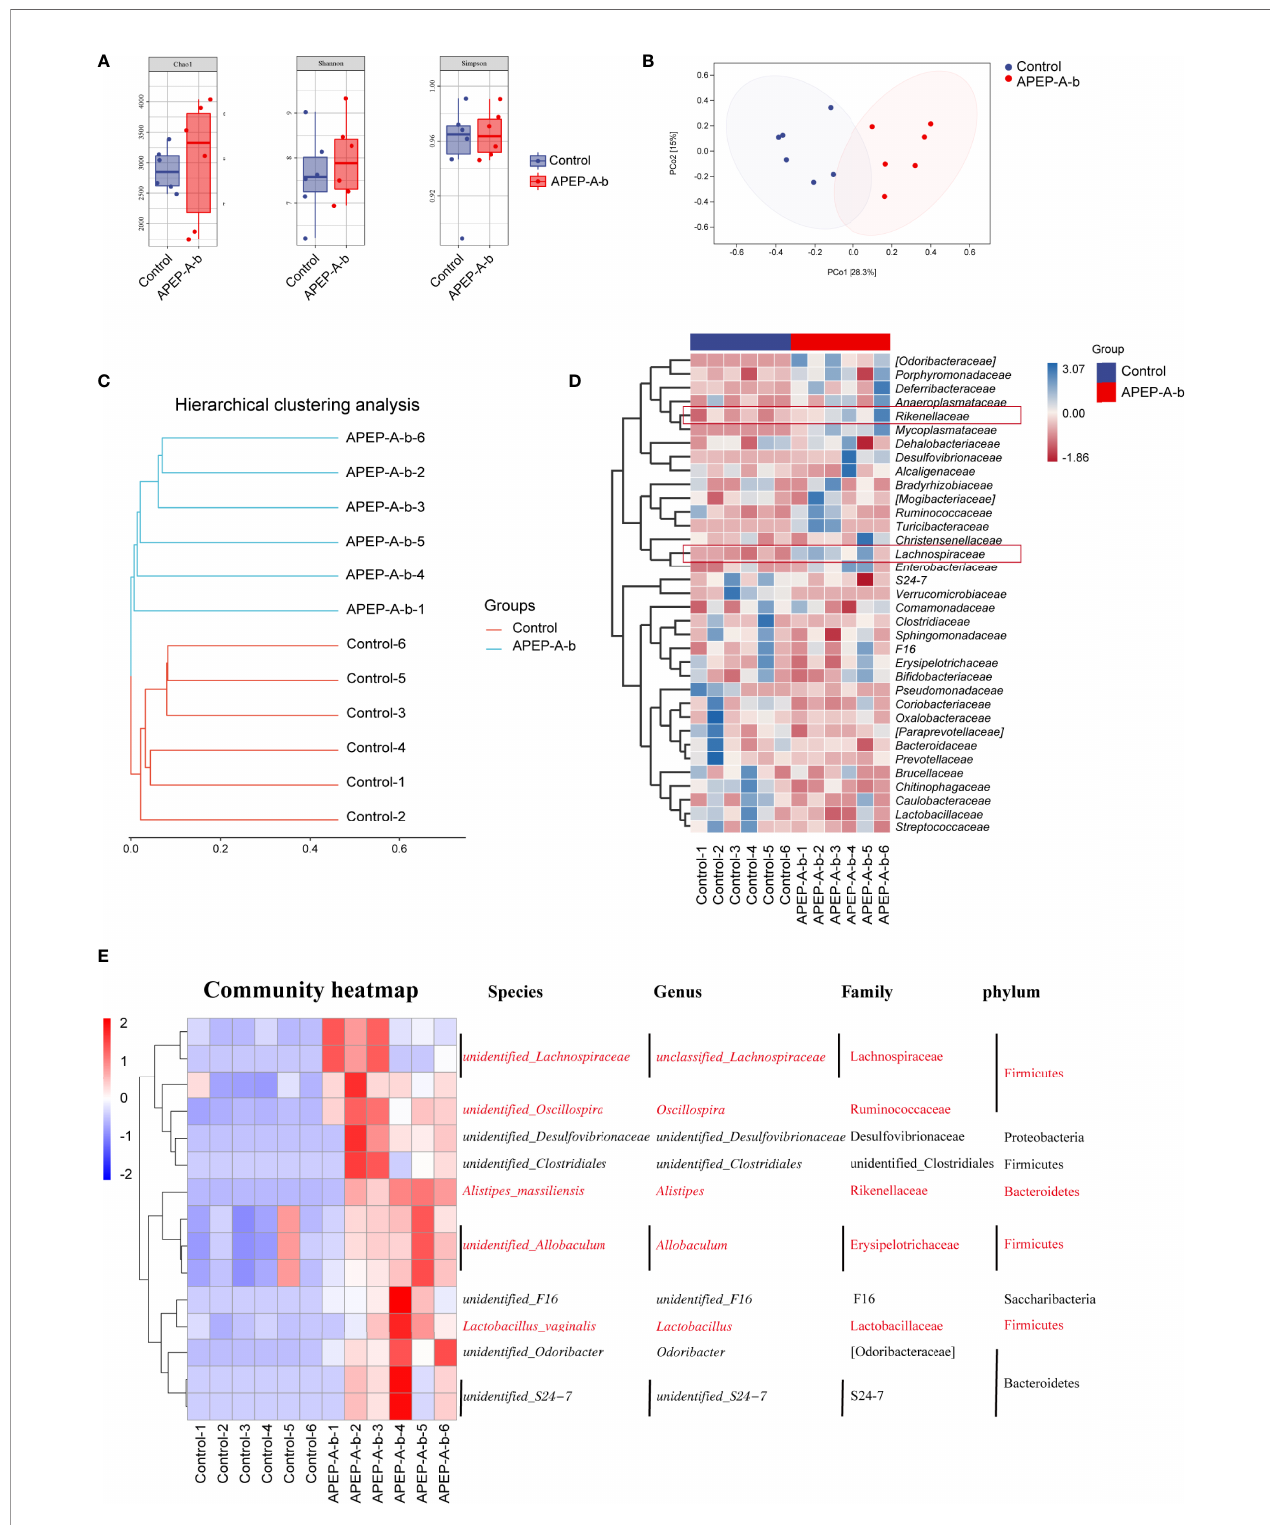
FIGURE 6 | Effects of APEP-A-b on gut microbiota composition tested by 16S rRNA sequencing. 16S rRNA sequencing results were characterized with (A) a - diversity, including Chao1, Shannon and Simpson, (B) the principal coordination analysis (PCoA) at the amplicon sequence variants (ASV), (C) cluster analysis, (D) heatmap of microbiota at family level, and (E) ASV level,